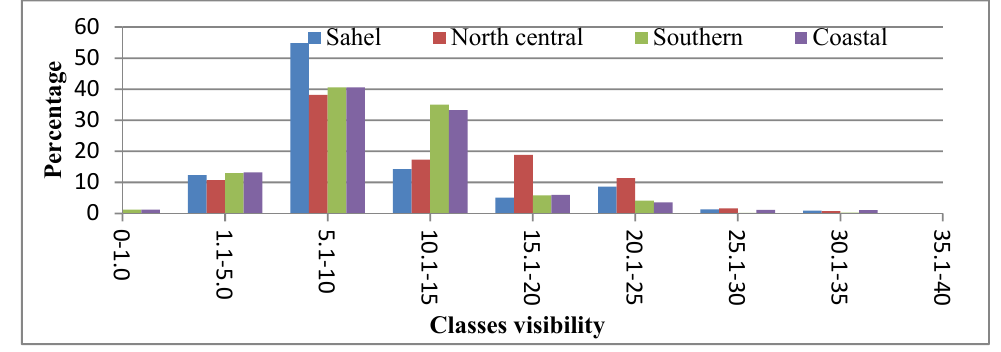
Figure 8. The distribution of frequency of visibility over 30 years period observed at four climatic zones of